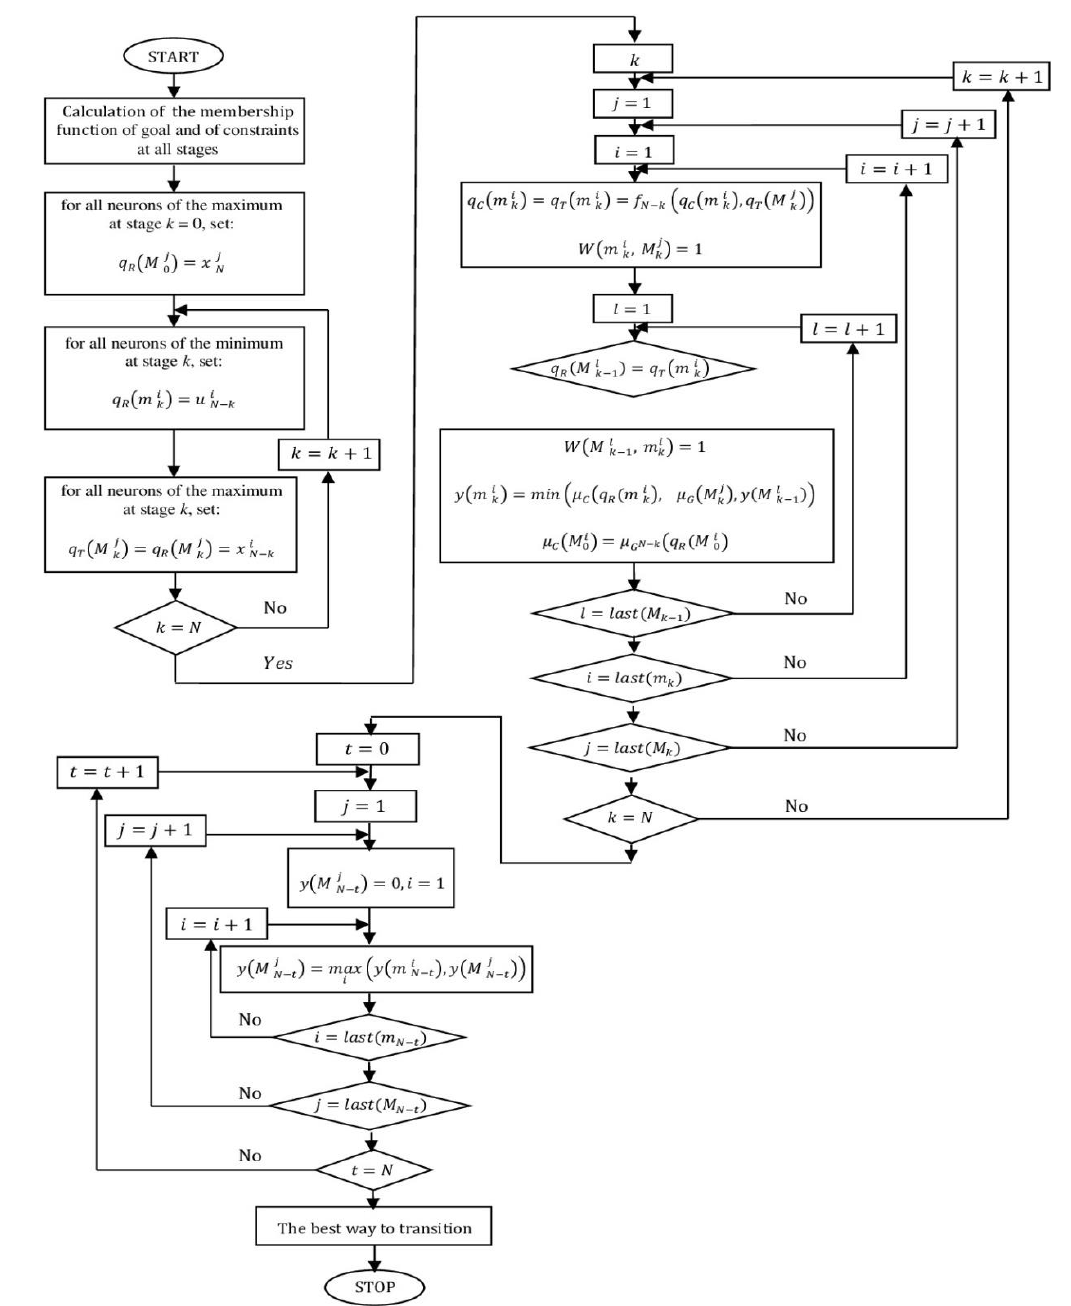
Figure 4. The flowchart of the fuzzy neural anticollision algorithm (FNAC).